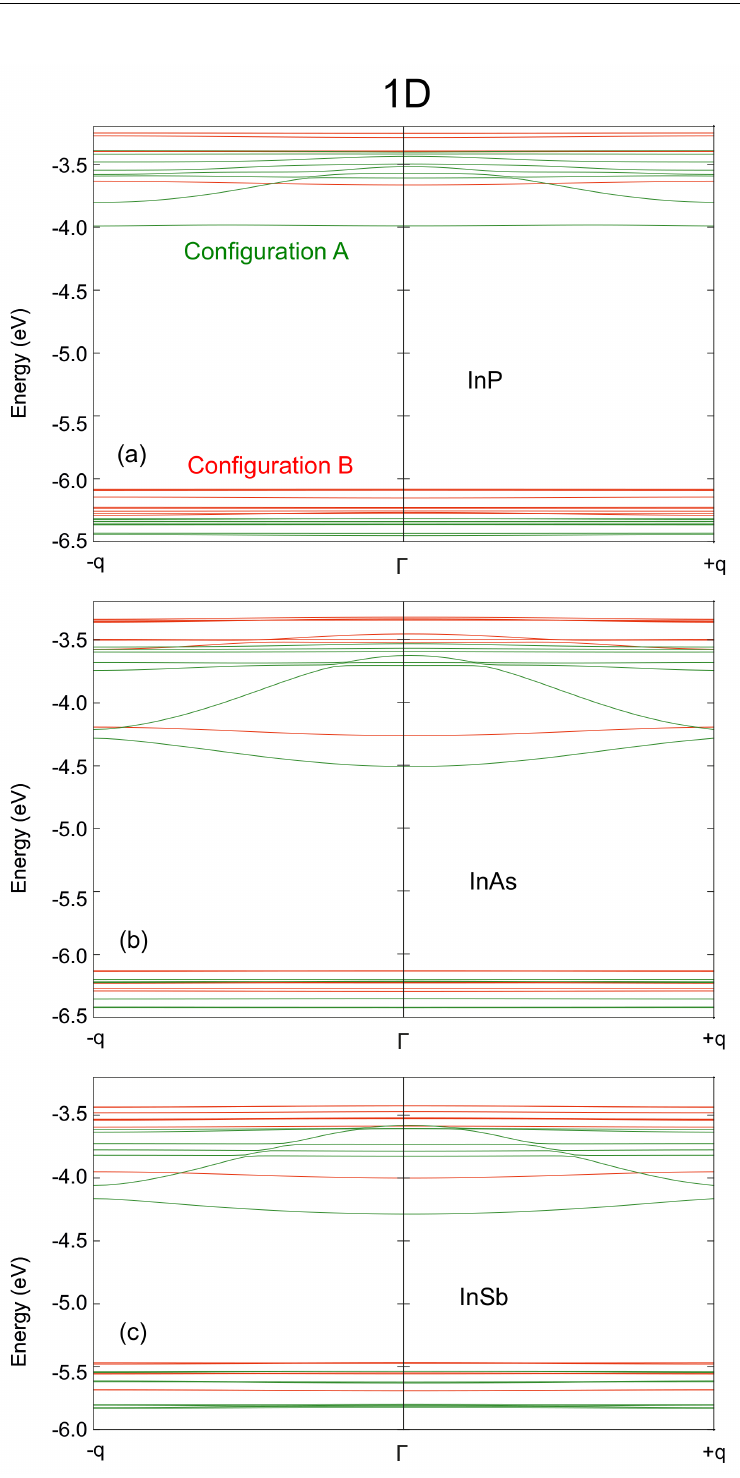
Figure 2. Miniband structure for 1D arrays of ( a ) InP, ( b ) InAs, and ( c ) InSb QDs with anion-rich (configuration A, green lines) and cation-rich (configuration B, red lines) surfaces. The energies on the vertical axis are relative to the vacuum level; the horizontal axis sweeps the Brillouin zone, q stands for π /2 R 1 , i.e., the limits of the Brillouin